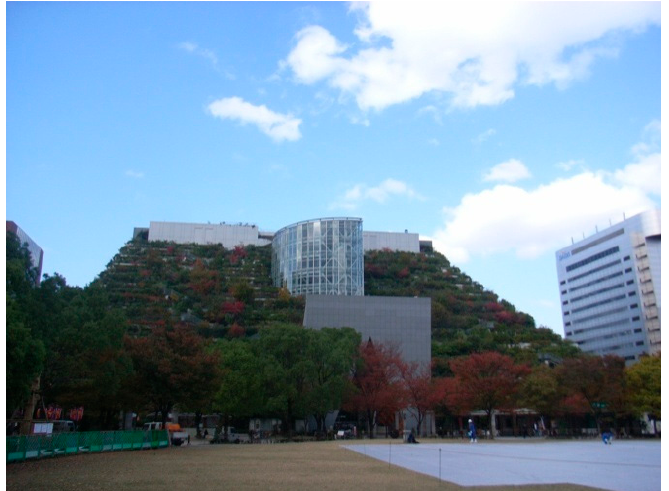
Figure 2. Green façade of the Prefectural International Hall “Asian Cross Road Over the Sea” from the side of the Tenjin Central Park; photograph by B. Majerska-Pa ł ubicka.